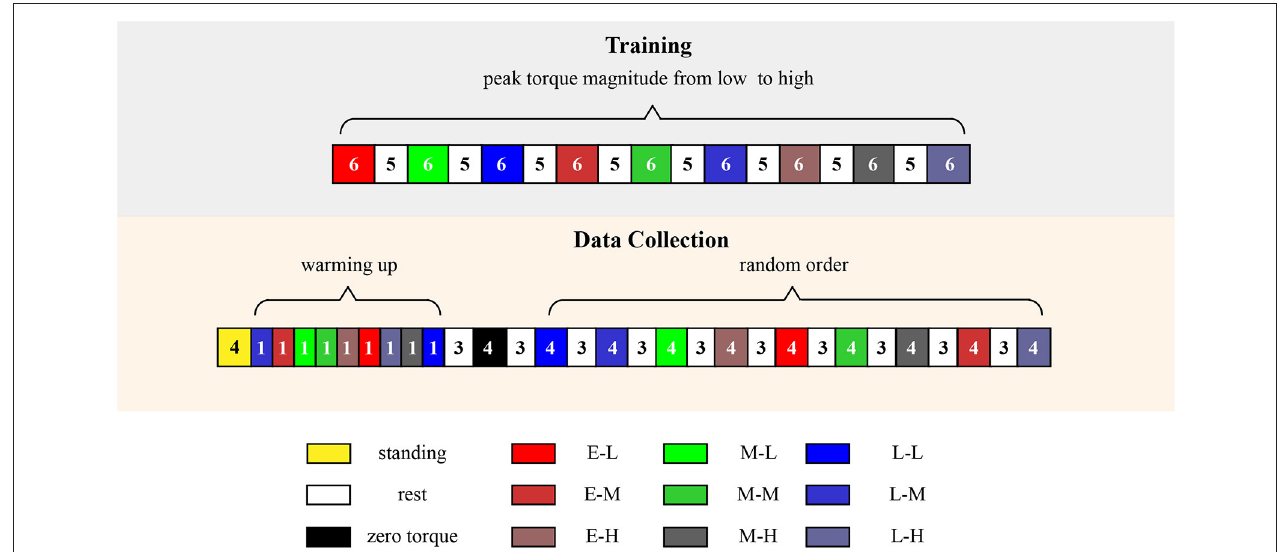
FIGURE 6 | Experimental protocol which includes a training session and a data collection session. Numbers in the box represent the time of the corresponding